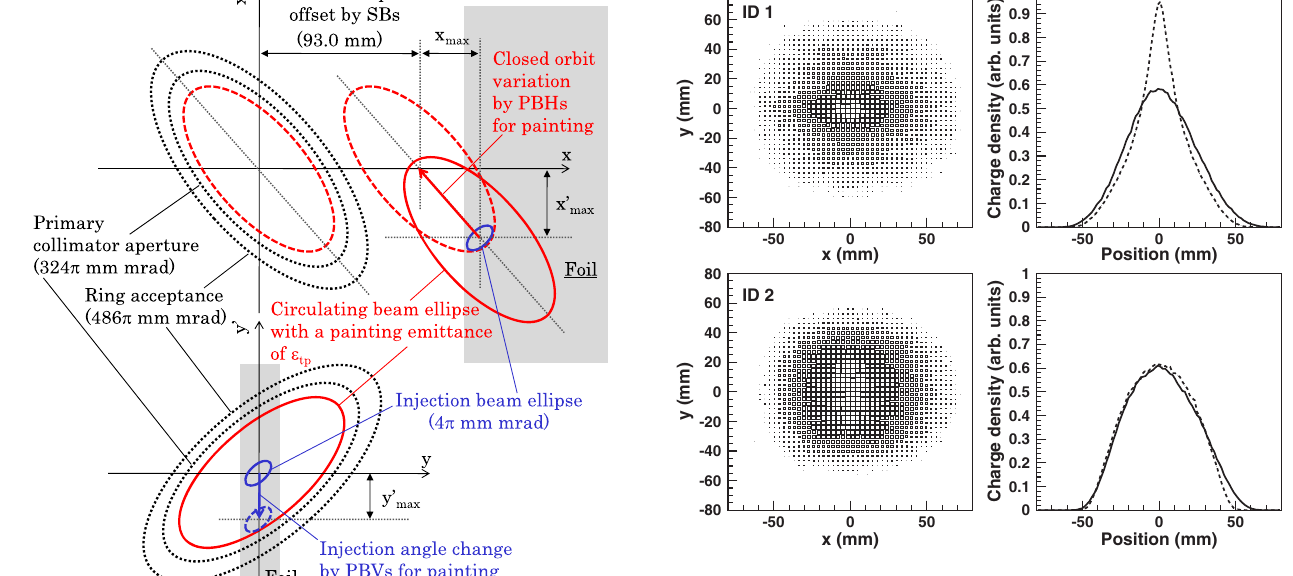
FIG. 5. Particle distributions on the two-dimensional transverse plane ð x; y Þ and their projections onto the x (solid curves) and the y (dashed curves) axes, calculated at the end of injection on the foil for the beam intensity of 539 kW with the painting parameter IDs 1 and 2 in Table II given later.